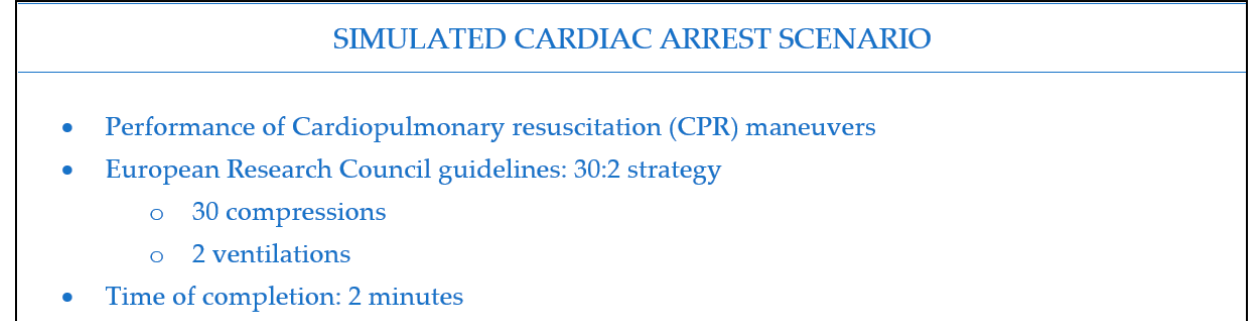
Figure 1. Schematic representation of the simulated cardiac arrest